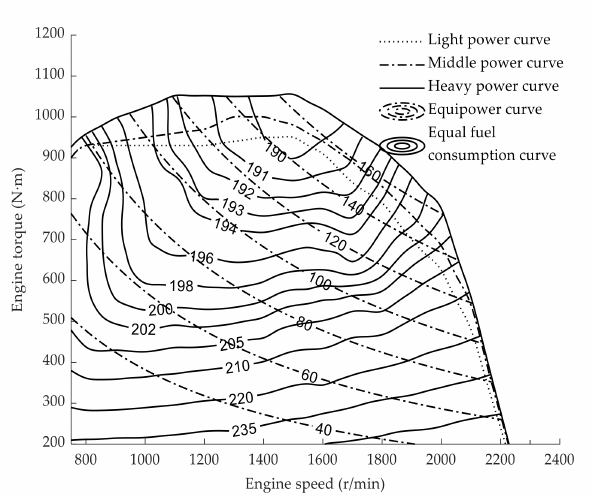
Figure 2. Universal characteristics of the